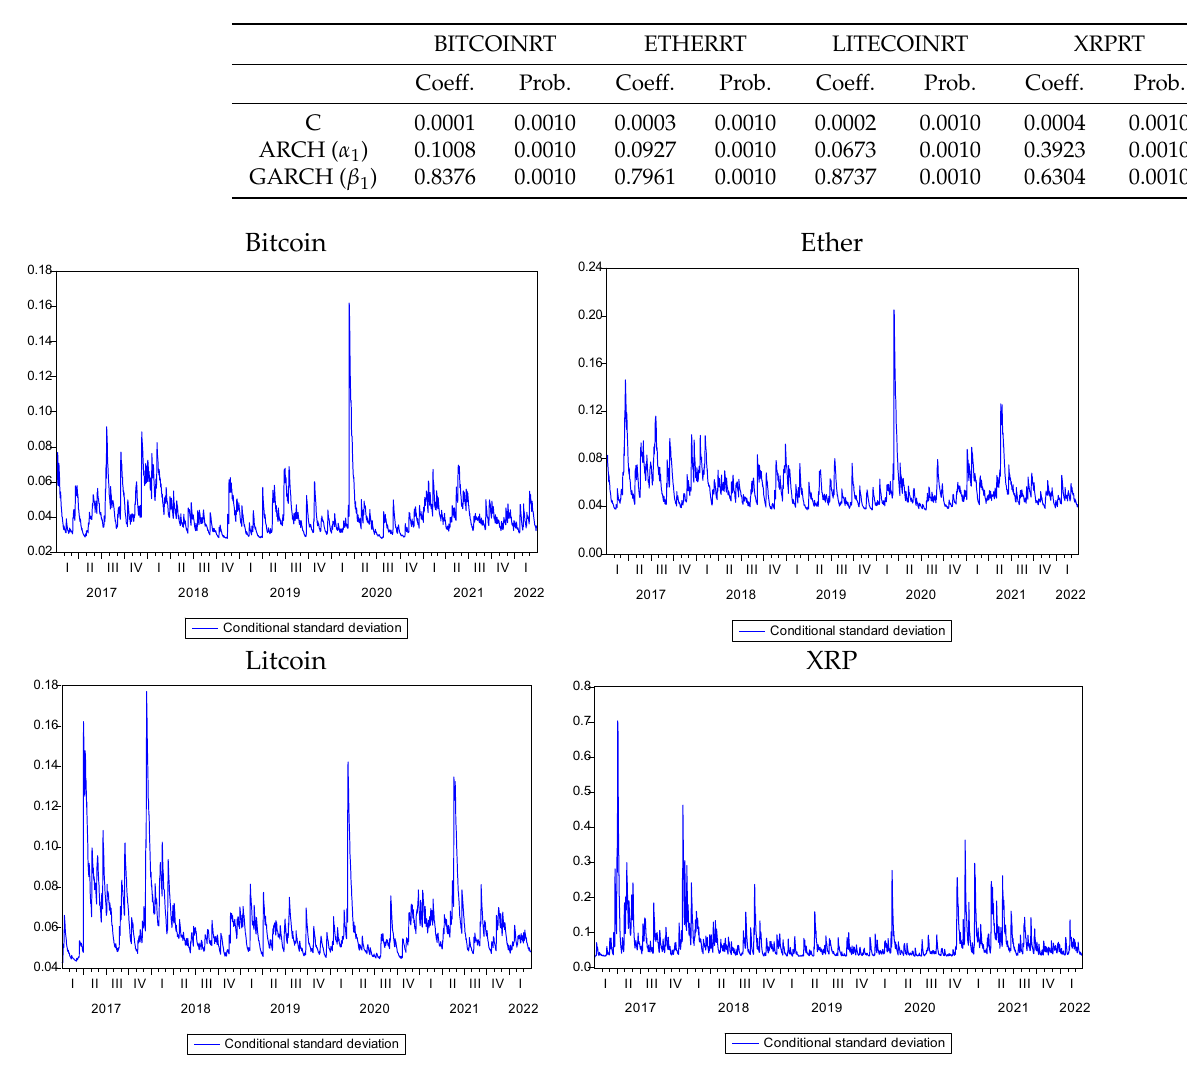
Figure 2. GARCH Values of Cryptocurrencies.